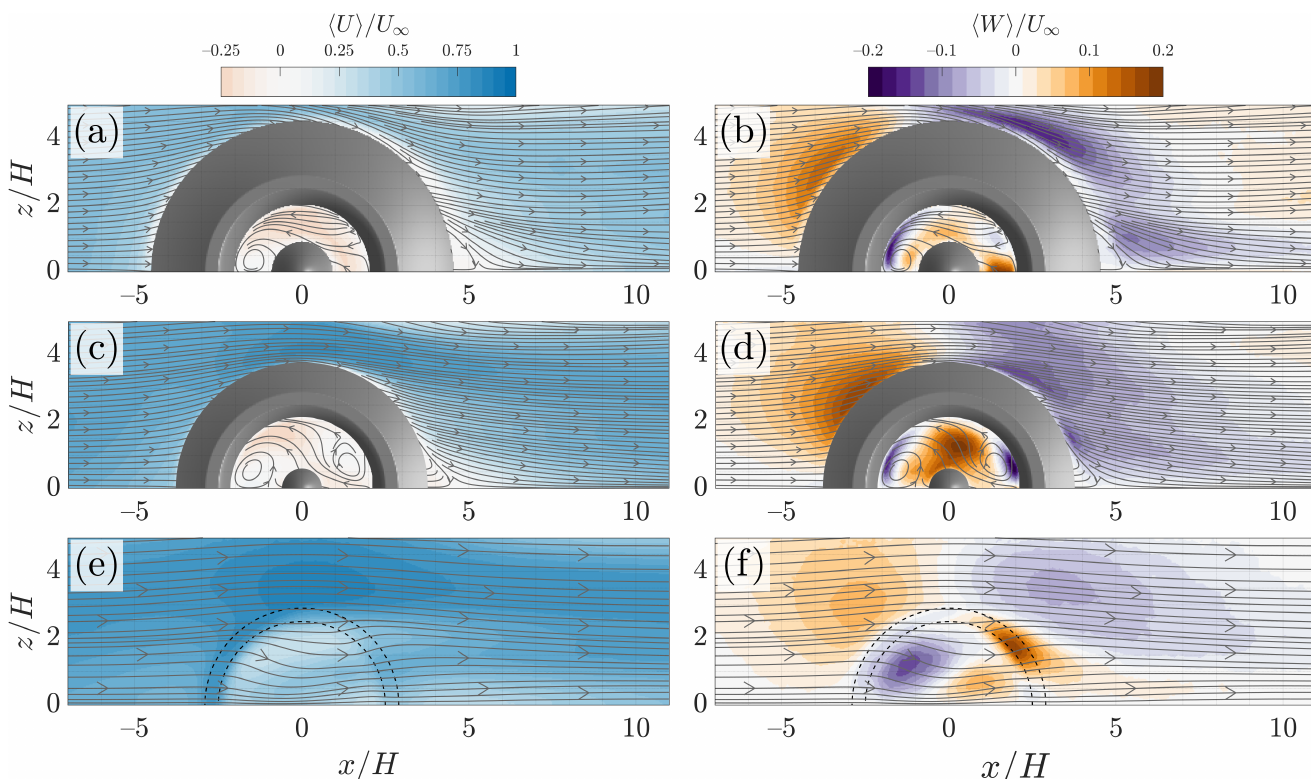
Figure 10. Contours of normalized (cid:104) U (cid:105) ( left ) and (cid:104) W (cid:105) ( right ) on the wall-parallel measurement planes located at ( a , b ) y / H = 0.3, ( c , d ) y / H = 0.6, and ( e , f ) y / H = 1.1. The location of the crater rim is indicated by the dashed lines for reference. Re H = 8.9 × 10 3